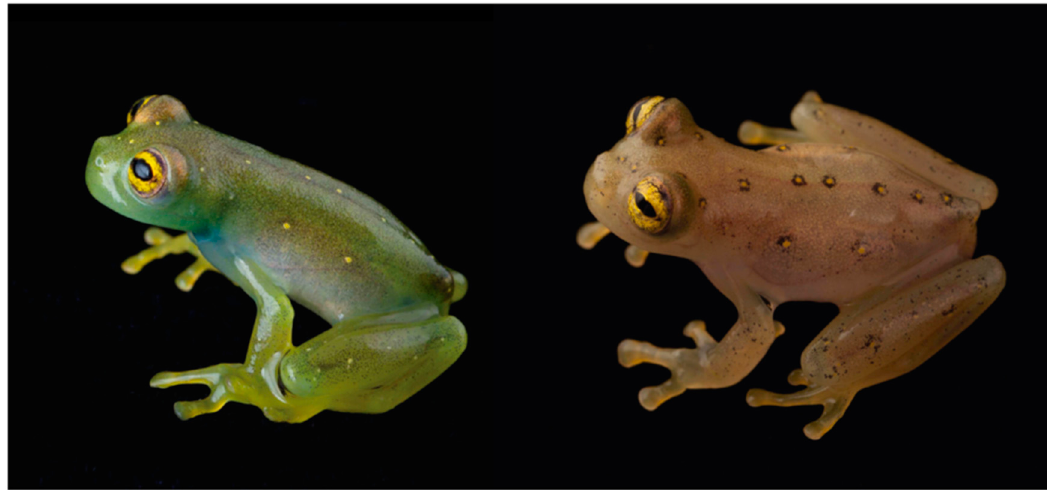
Figure 128. Ontogenetic color change in Nymphargus anomalus , QCAZ 48107. Photos by Luis A. Coloma.